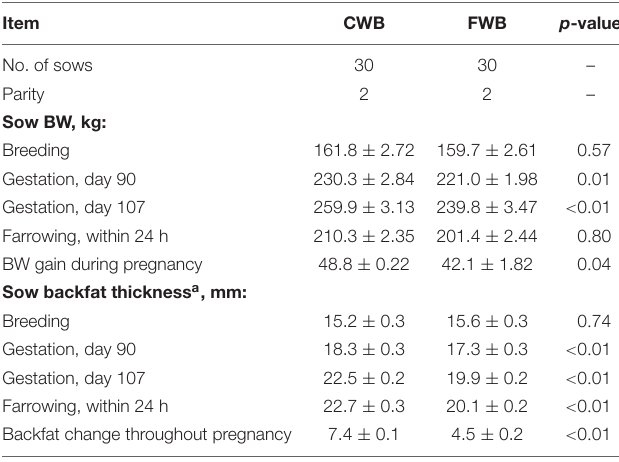
TABLE 2 | Effect of feeding sows a gestation diet containing different particle sizes of wheat bran on sow body condition during gestation.